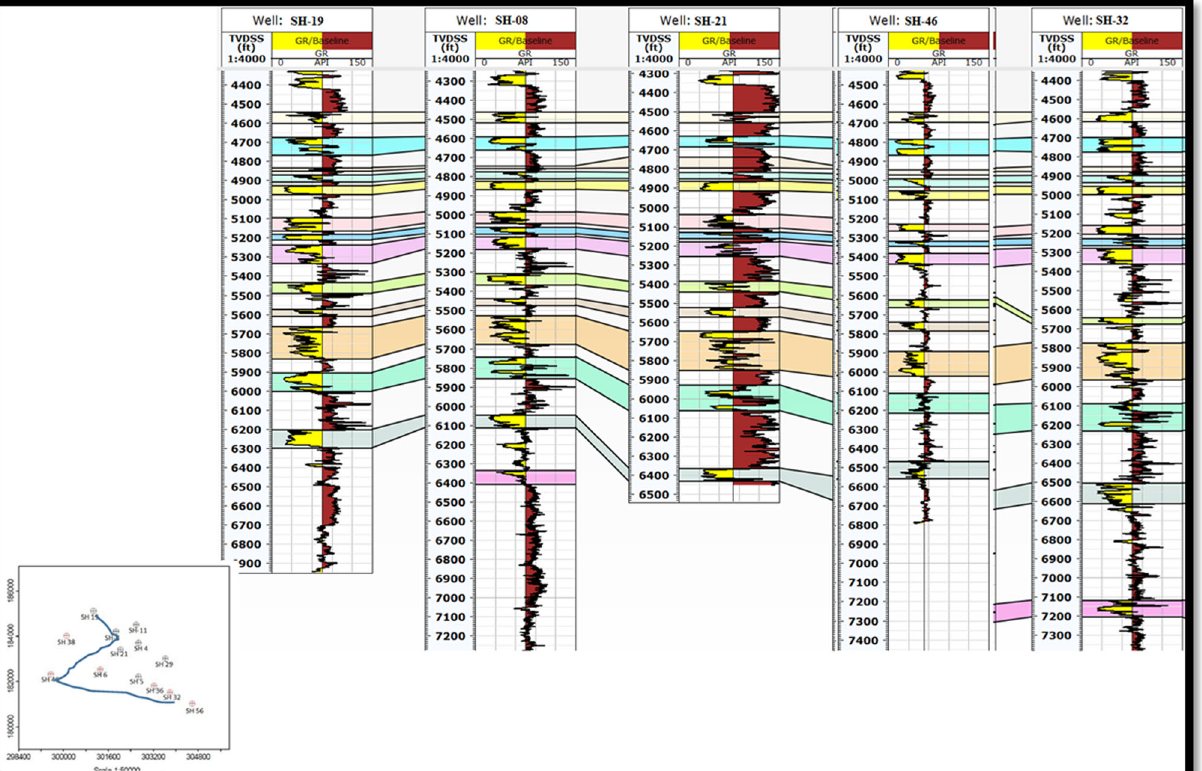
Fig. 7 Correlation panel showing the continuity of the sand and shale